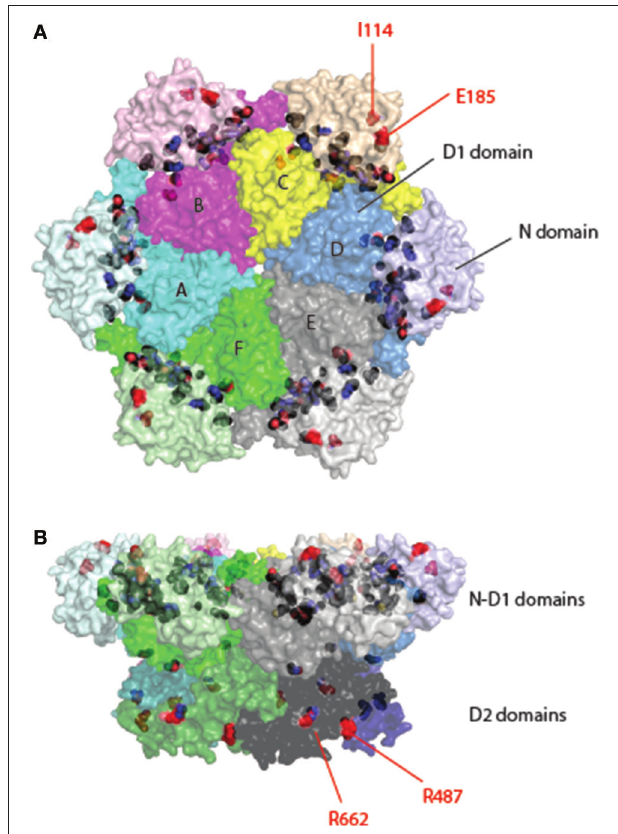
FIGURE 5 | Location of pathogenic mutations in the structure of full-length p97. Surface representation of the structure of p97 is decorated with pathogenic mutations in p97 identified from patients of various muscular and neurological disorders. Each subunit is given a unique color with distinct shades for different domains. Interface mutations are colored in black and non-interface mutations in red and labeled. The non-interfacial mutations are mostly identified in ALS patients. (A) Top view. (B) Side